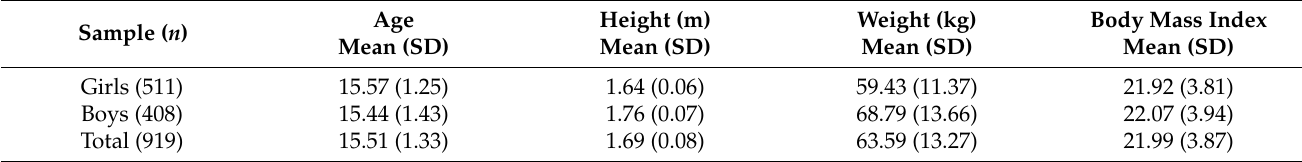
Table 1. Sociodemographic data of the sample composed by 919